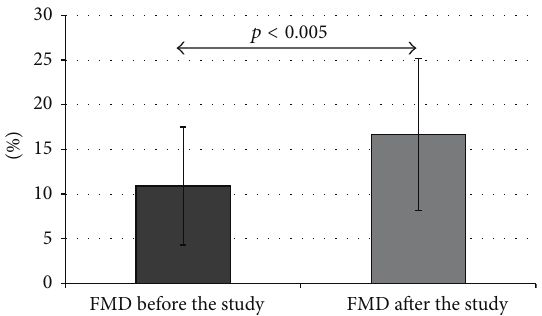
Figure 1: FMD in the whole study group before and after the study (data presented as mean ± SD).